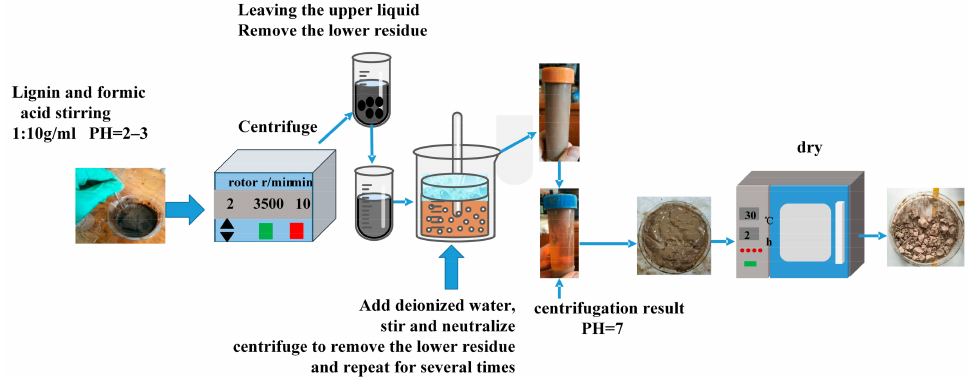
Figure 2. Extraction process of creating formic acid